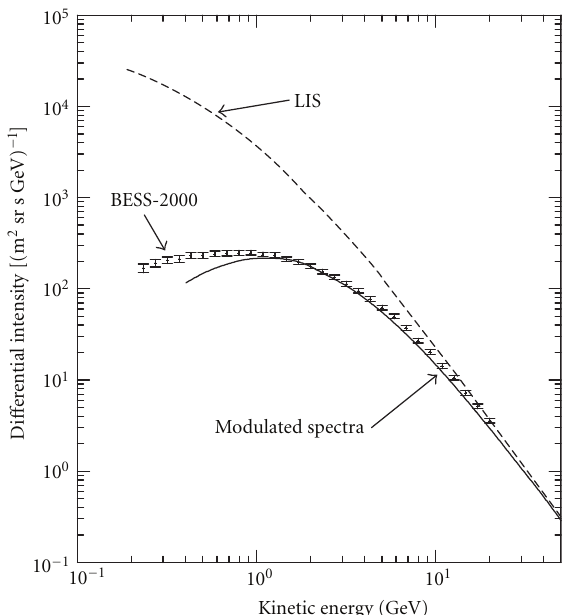
F 8: Proton differential intensity determined with the HelMod code (continuous line) compared to the experimental data of BESS- 2000; the dashed line is the LIS (see the text).